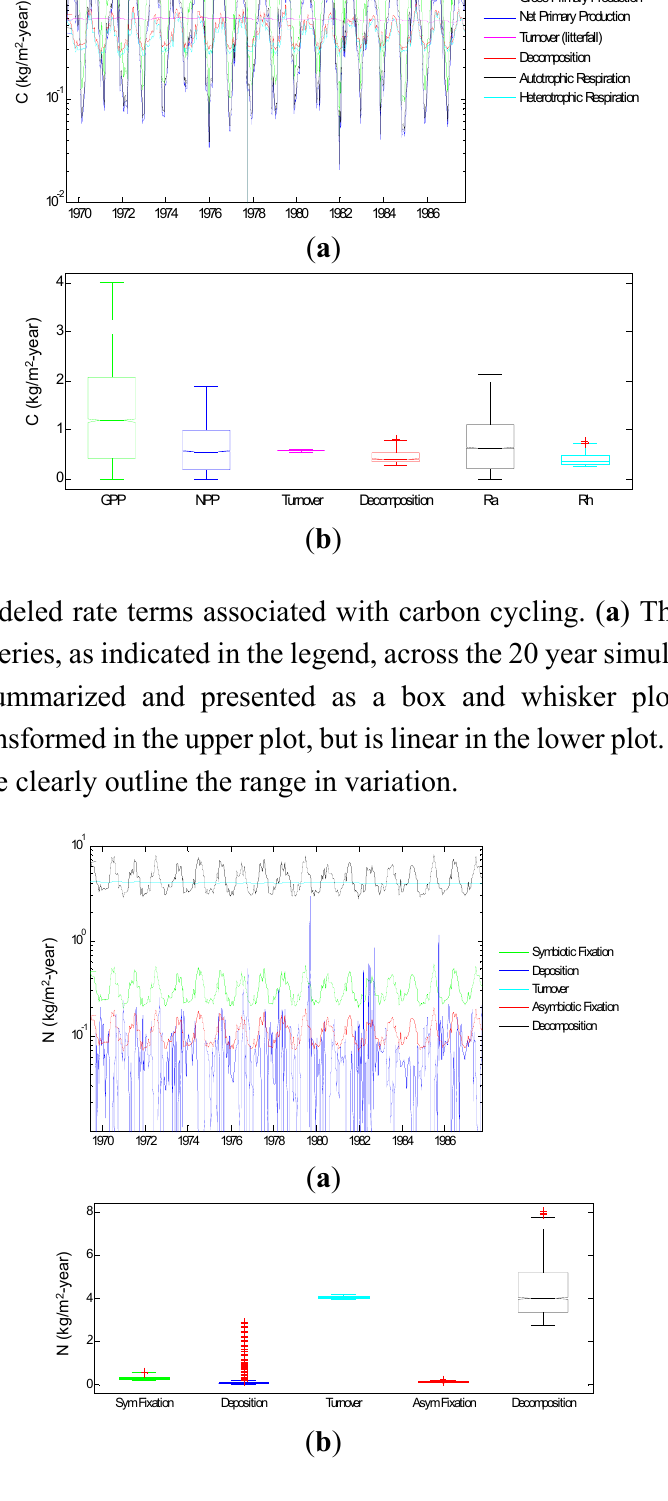
Figure 7. Key modeled rate terms associated with the input of nitrogen into the system. ( a ) The plot represents the modeled time series, as indicated in the legend, across the 20 year simulation time frame. These data are summarized and presented as a box and whisker plot ( b ). Note that the y axis is log transformed in the upper plot, but is linear in the lower